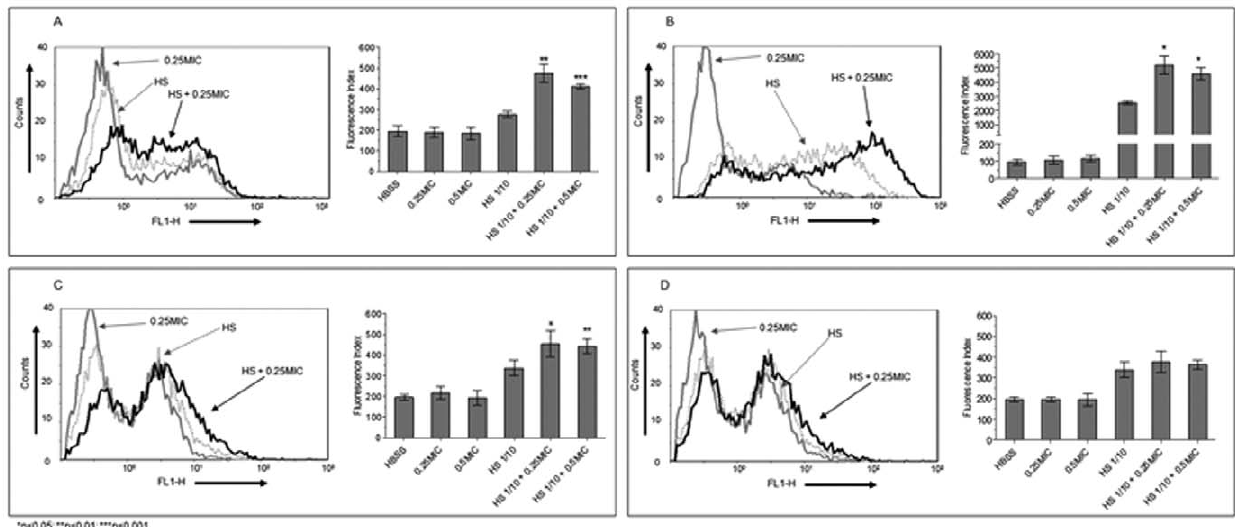
Figure 1. In vitro opsonophagocytosis using HL-60 cell line. Flow cytometry histograms and the corresponding fluorescence indices showing opsonophagocytosis for Strain 1 (A), Strain 3 (B), and Strain 2 with cefditoren (C) and ceftriaxone (D).